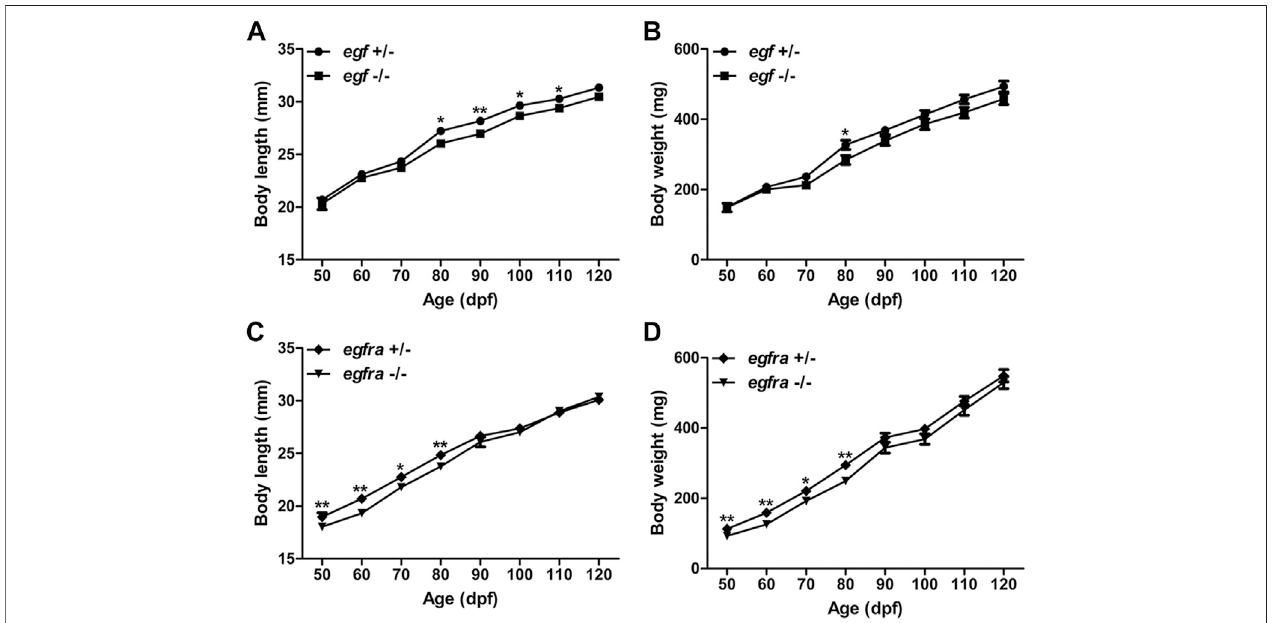
FIGURE 2 | Growth performance of egf and egfra mutant males. (A,B) The standard body length and body weight of egf − / − fi sh were comparable with those of egf +/ − fi sh with slight decrease after 70 dpf. (C,D) The standard body length and body weight of egfra − / − fi sh were slightly below those of egfra +/ − fi sh from 50 to 80 dpf, and they became comparable after 90 dpf. * p < 0.05; ** p < 0.01 ( n (cid:1) 19 –